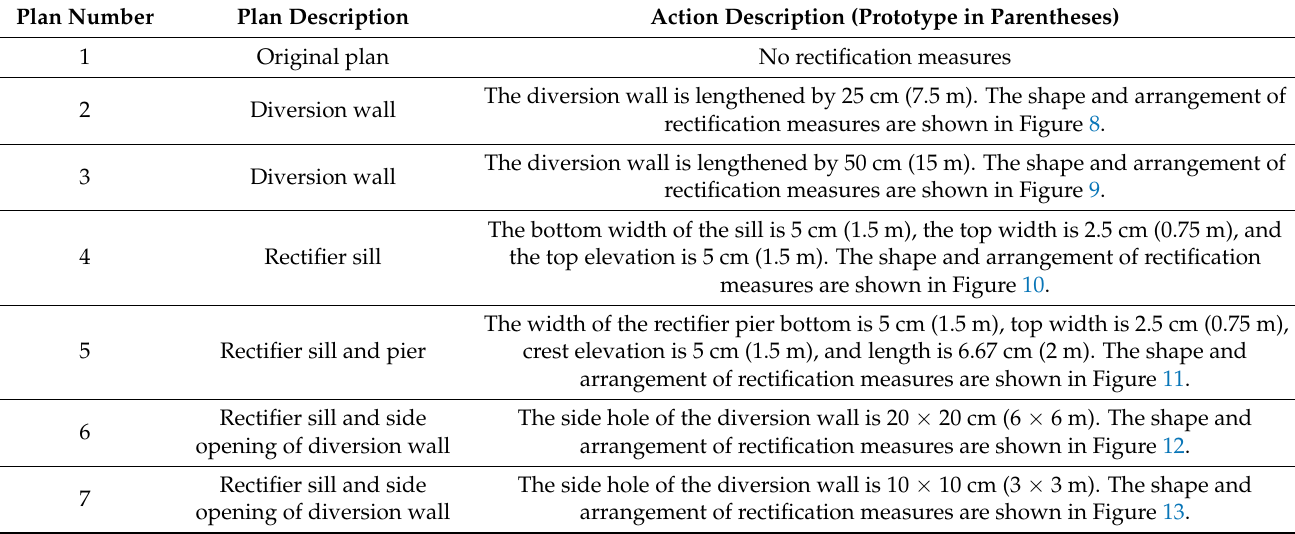
Table 3. List of test plans for flow pattern of the pumping